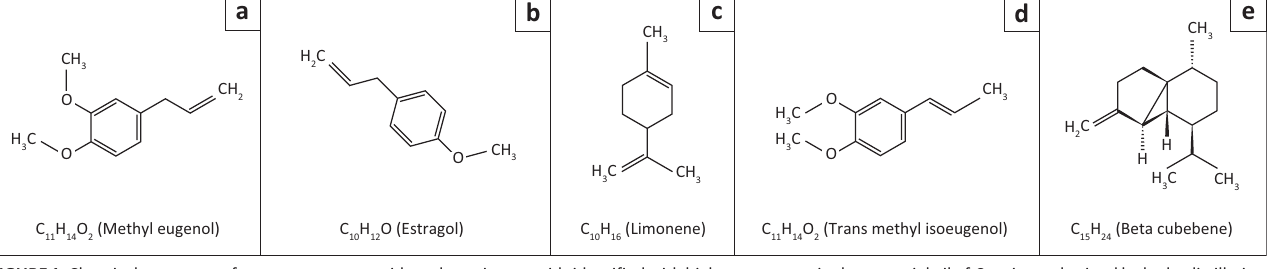
FIGURE 1: Chemical structures of some monoterpenoids and sequiterpenoids identified with high percentages in the essential oil of C. anisata obtained by hydrodistillation and solvent-free microwave extraction by using gas chromatography–mass spectroscopy analysis.